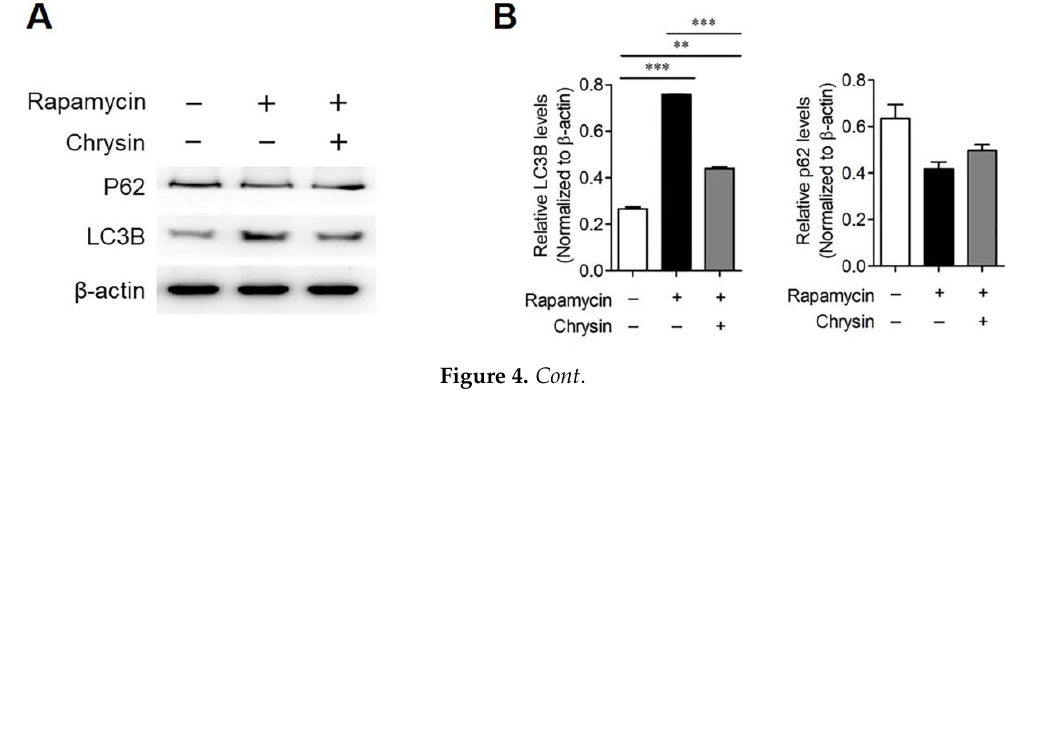
Figure 4. Autophagy was inhibited by chrysin in the A/PR/8-infected A549 cells. ( A ) The culture medium of A549 cells was pretreated with a control (DMSO) or 500 nM rapamycin for 1 h and was then treated with 50 µ M chrysin. After 1 h, cell lysates were collected and subjected to Western blot analysis. ( B ) The ratios of LC3B to β -actin levels and p62 to β -actin levels based on the quantification of the bands in the immunoblot shown in ( A ). ( C ) Western blot analysis results of LC3B and NP in A/PR/8-infected and non-infected A549 cells after treatment with chrysin (50 µ M) for 24 and 36 h. ( D ) Expression levels of LC3B and NP normalized to that of β -actin are shown in the right panel. ( E ) Western blot analysis to detect mTOR and p-mTOR in A/PR/8-infected and non-infected A549 cells after 12 h of treatment with a vehicle or 50 µ M chrysin. ( F ) The ratios of p-mTOR to β -actin levels based on the quantification of the bands in the immunoblot shown in ( E ). Data are expressed as mean ± SD of the values obtained from three independent experiments. * p < 0.01, ** p < 0.001, and *** p < 0.0001 based on ANOVA with Bonferroni’s multiple comparison test.